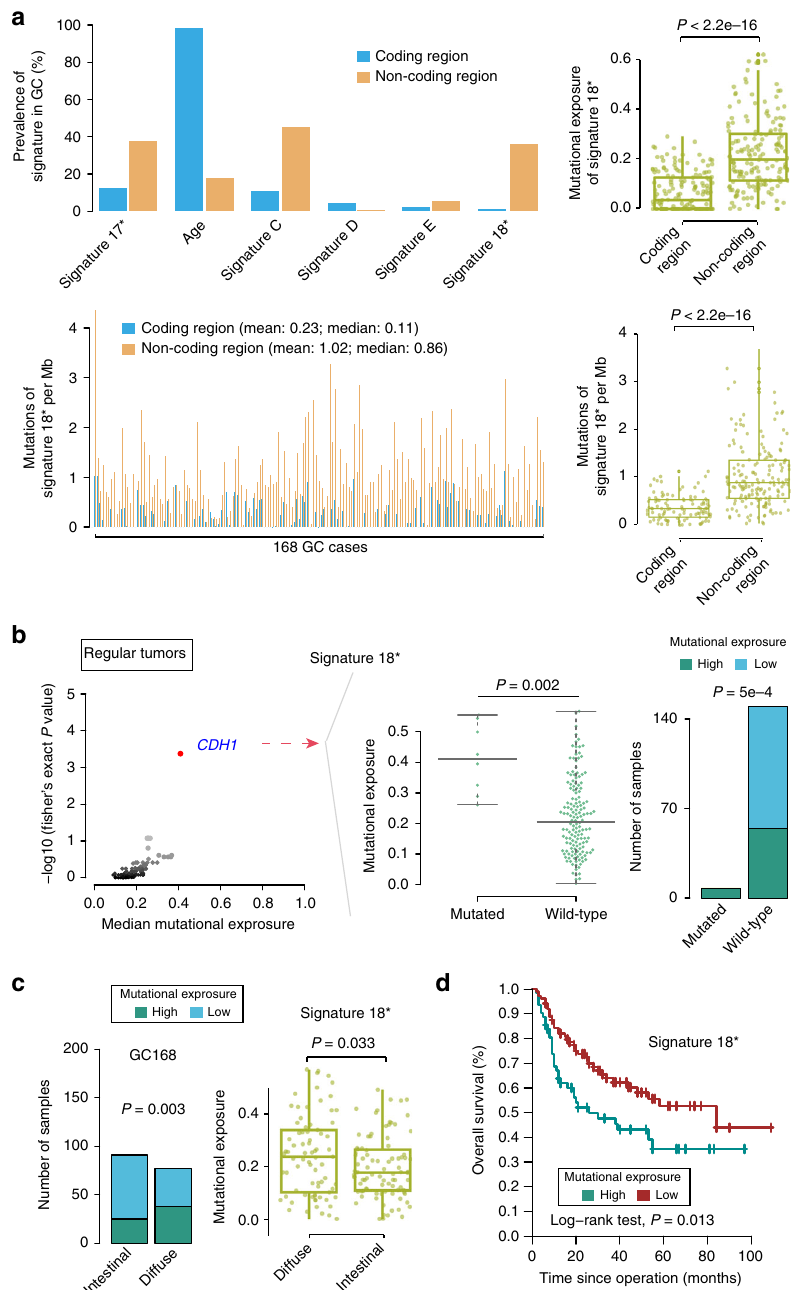
Fig. 6 Summary of the presence of mutational signature 18* in 168 GC specimens. a Prevalence of each mutational signature and mutation of signature 18* per Mb across GCs between noncoding and coding regions. In the left panel, the X -axis shows the signatures or each sample, and the Y -axis shows the proportion of samples or mutation of signature 18* per Mb in the coding or noncoding region. Mutational exposure or mutation of signature 18* per Mb of signature 18* in the coding or noncoding region was revealed (right). One dot represents one sample. P values were derived from t tests. b (left) Mutational-exposure analysis revealed an association between somatic CDH1 mutations (regular tumors referred to those which are without somatic hypermutation) and mutational signature 18*. High mutational-signature contribution was de fi ned as GC with mutational-signature contributions >25%. Genes mutated in >4% of samples were chosen from our cohort. Genes with a false discovery rate ( q ) <0.1 are highlighted in red. CDH1 was the only gene showing a signi fi cant difference. The P value for evaluating mutational-exposure between CDH1 status was derived from t tests. Center line of boxplot represents the median of mutational exposure of signature 18*. b (right) The contribution of signature 18* was compared in wild-type versus mutated tumors. P values were derived from Fisher tests. c Relationship between signature 18* and diffuse-type GC in our cohort. One dot represents one sample. P values were derived from Fisher tests and t tests. d Kaplan − Meier survival curves show the survival outcomes of signature 18* in GC. High mutational- signature contribution represents mutational-signature contributions ≥ 25%. GC gastric